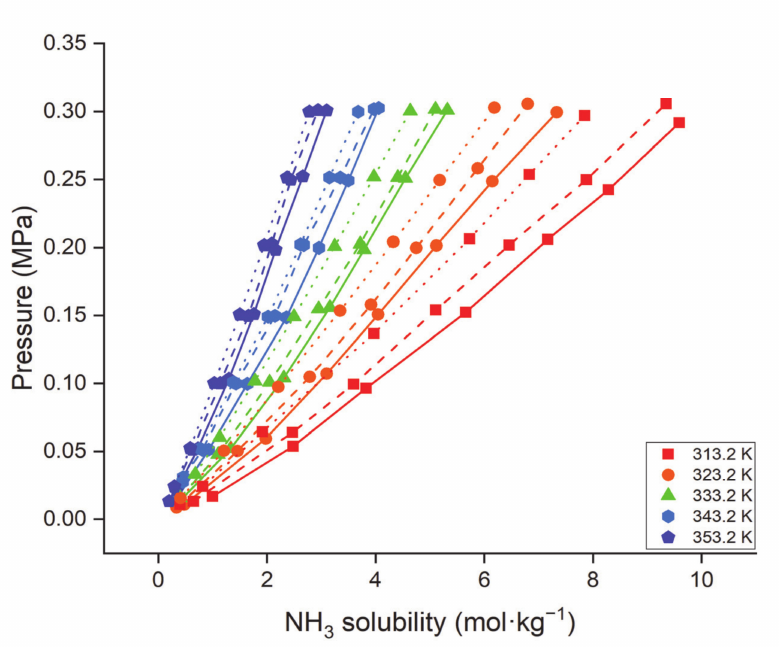
Figure 11. Effect of pressure, temperature, and molar ratio on the absorption capacity of NH 3 through EACl/acetamide based DESs; solid, dash, and dot lines indicate the 1:1, 1:2, and 1:3 EACl/acetamide molar ratios, respectively. Data are taken from